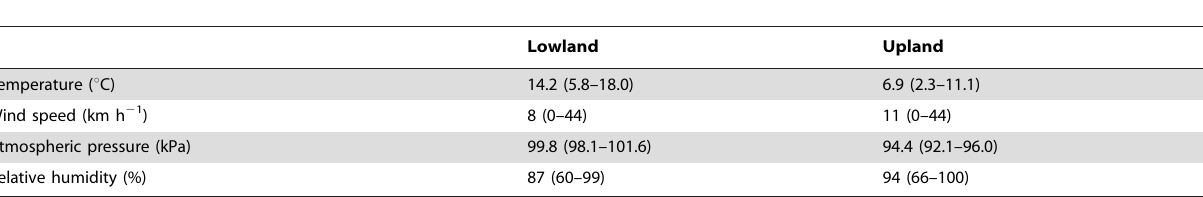
Table 1. Meteorological data recorded during the methane data collection periods. Values are means (minimum – maximum).